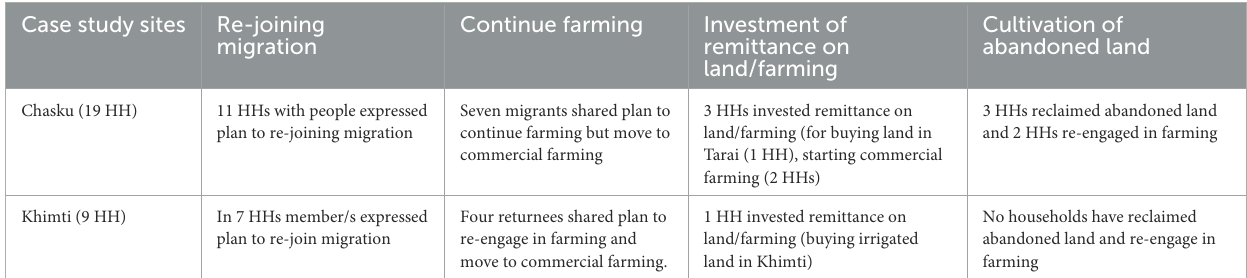
TABLE 4 Migration returnees’ decision on future livelihood